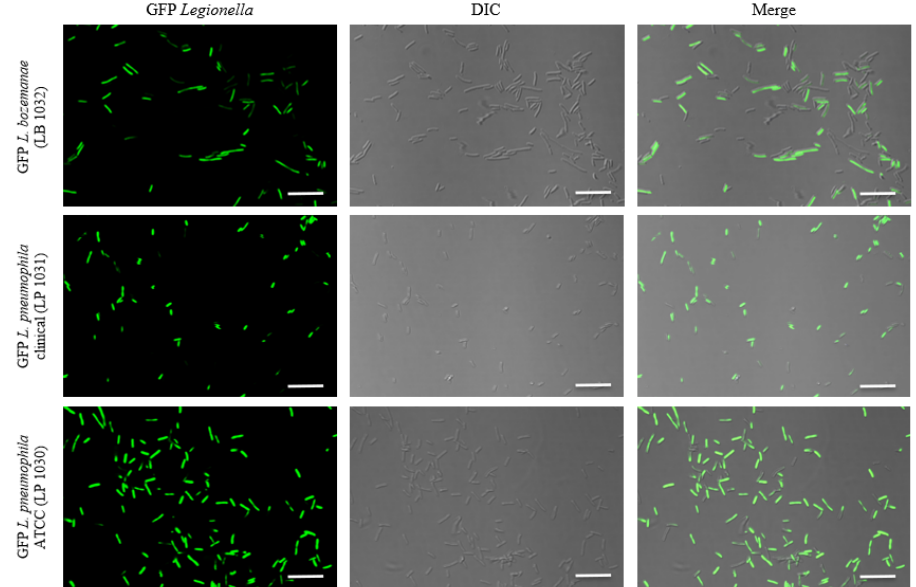
Figure 1. Differential interference contrast (DIC) and confocal microscopy of the GFP-expressing L. pneumophila and L. bozemanae strains imaged with a Zeiss LSM 700 confocal microscope. Images were generated using a 40× oil immersion objective. The panel on the far right represents the merged DIC and fl uorescence channels. The scale bar represents 10 μ m. ATCC, American Type Culture Collection; GFP, green fluorescent protein.